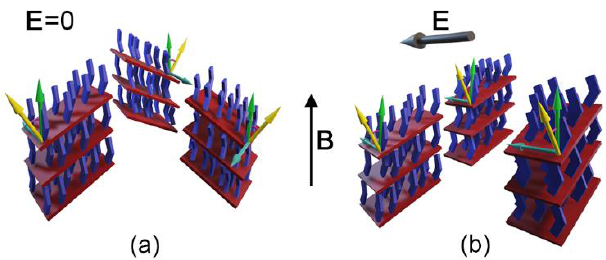
Figure 6. Alignment of cybotactic groups: ( a ) with no electric field E field applied, cluster dipoles are randomly oriented around the direction of the nematic director n , parallel to the magnetic field B ; ( b ) upon application of an electric field orthogonal to B , cluster dipoles align along E . For each group, the green, light blue, and yellow arrows indicate the average direction of the long molecular axes, the average direction of molecular dipoles, and the layer normal, respectively. Adapted from [6], Copyright 2018, with permission from Elsevier.